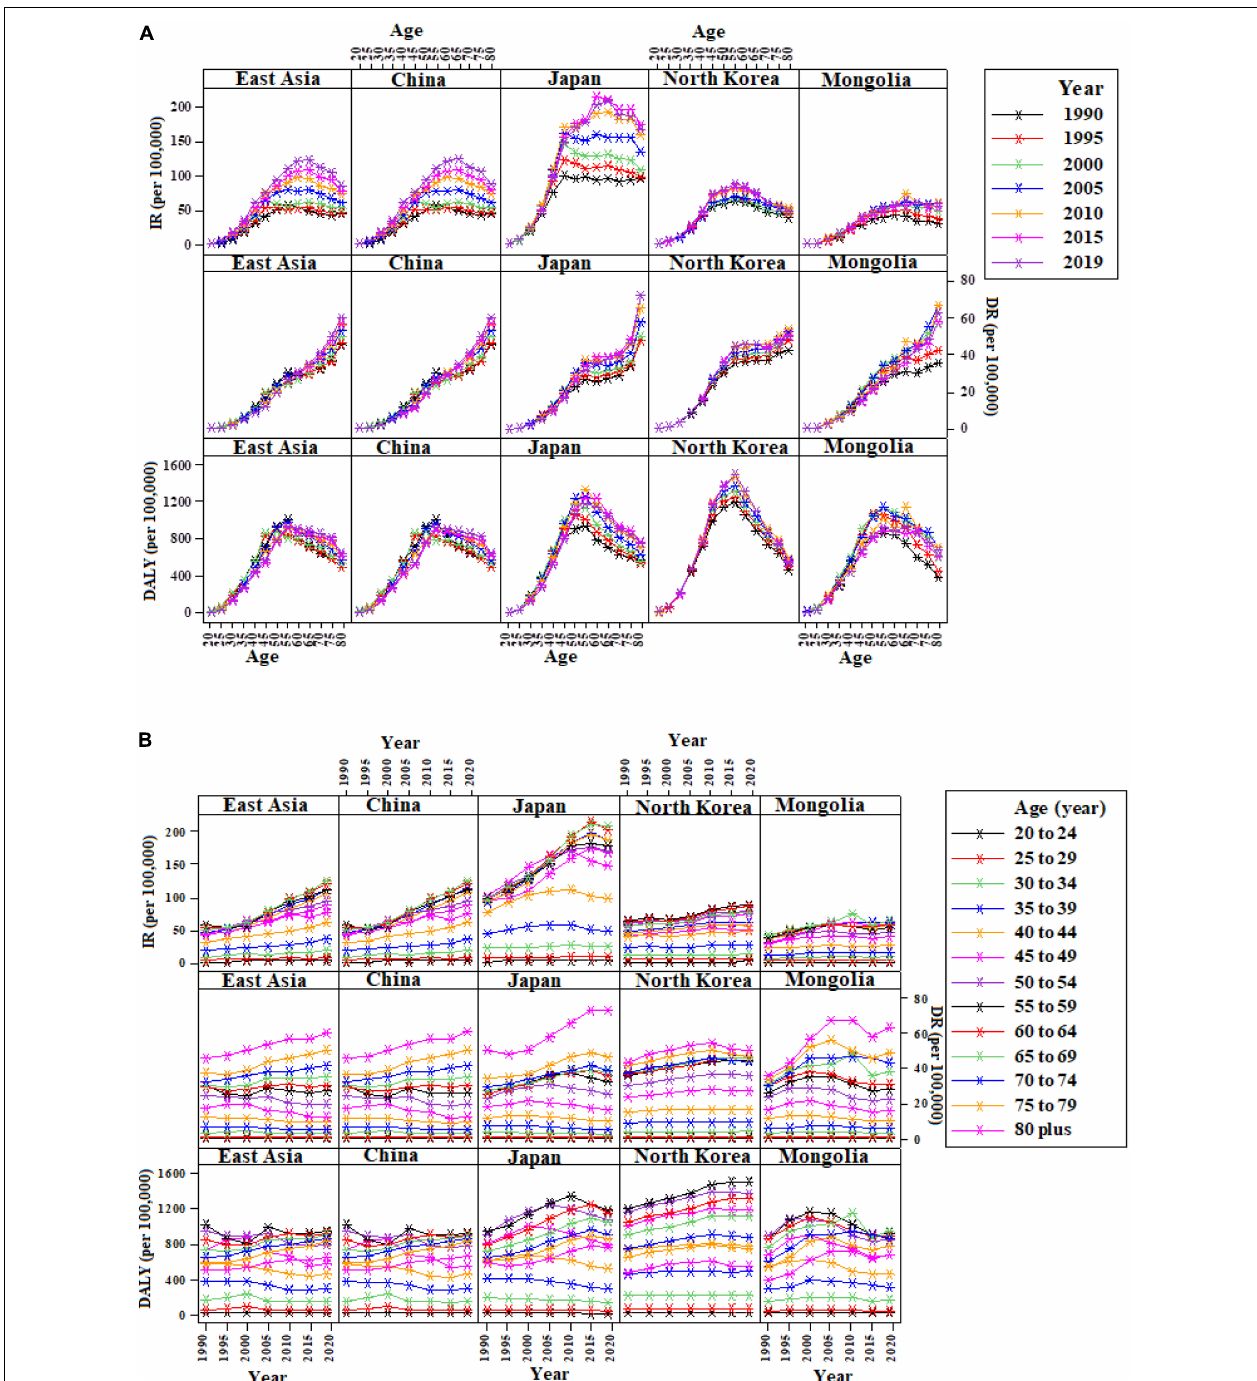
FIGURE 1 | Incidence, death, and disability-adjusted life years (DALYs) trends by age and period for female breast cancer (BC) in East Asia. (A) Incidence, death, and DALYs trend by age in East Asia, 1990–2019; (B) incidence, death, and DALYs trend by period in East Asia, 20–80+ years. IR, Incidence rate; DR, Death rate.